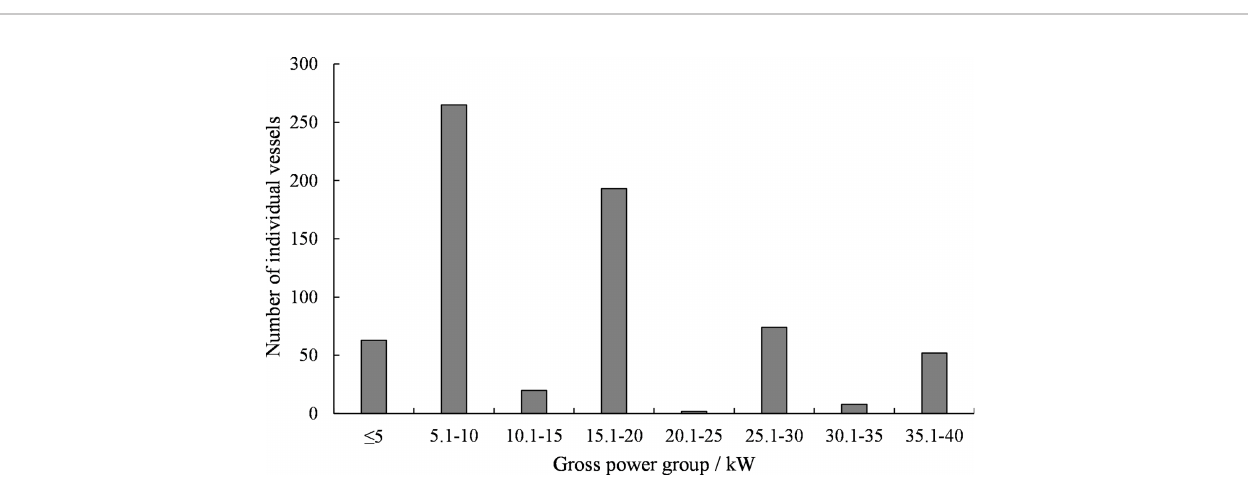
Table 2 summarized the main fi ndings of the questionnaire surveys. Of all the respondents (n=97), 88 were fi shing vessel